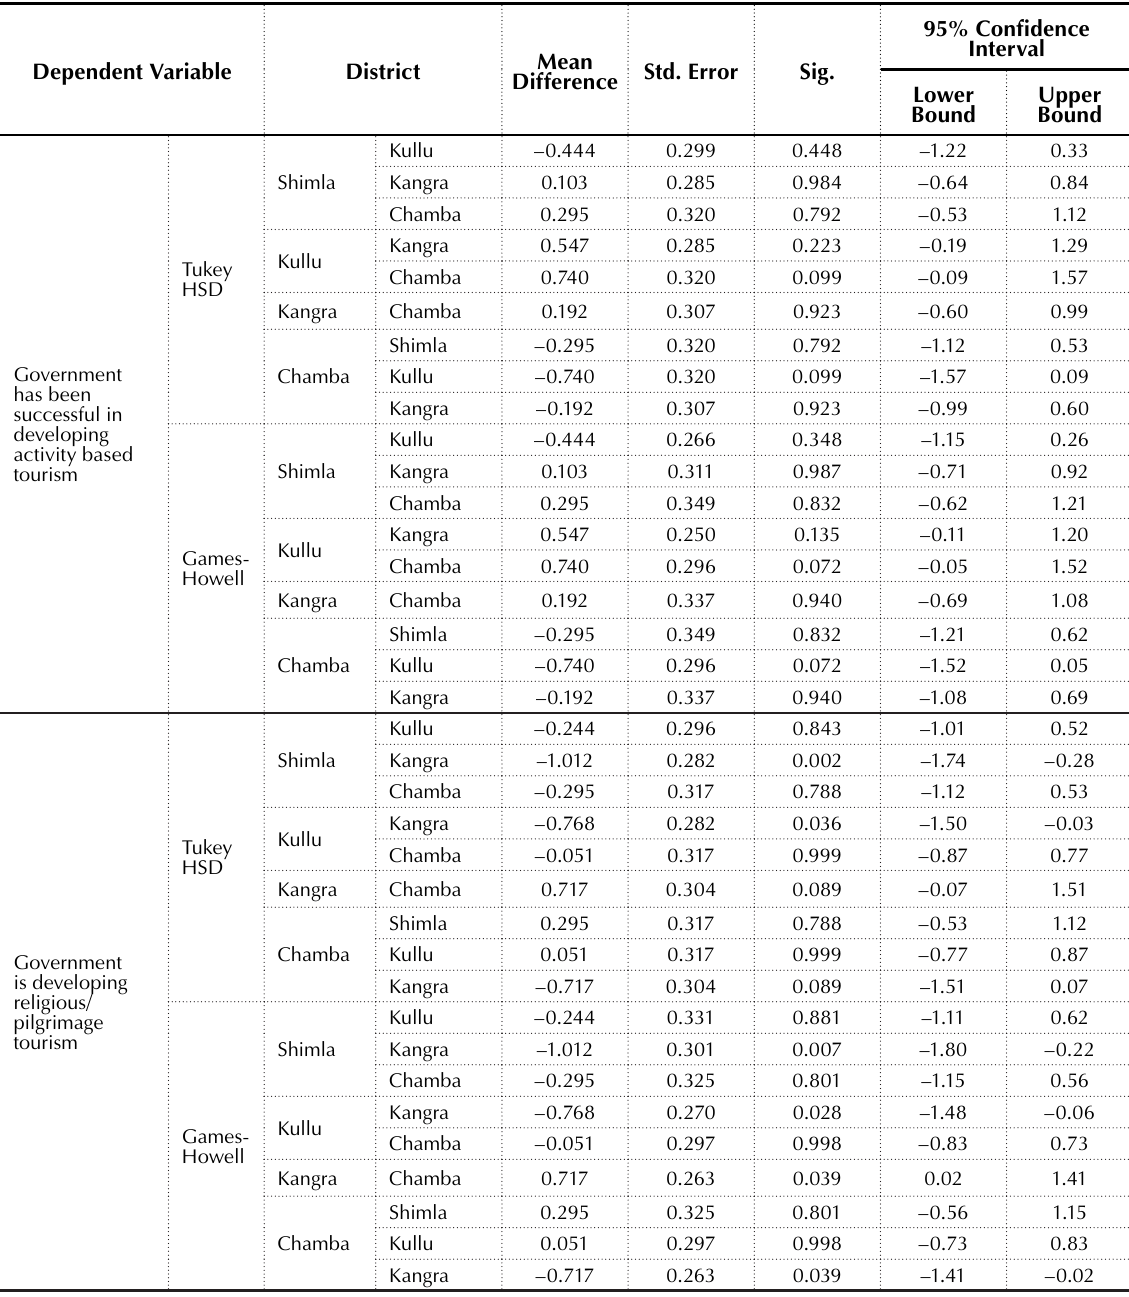
Source: primary data colected for this